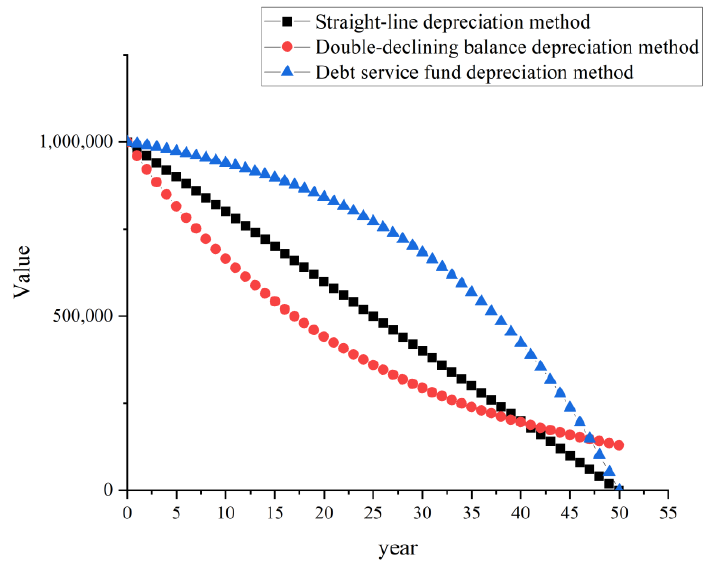
Figure 1. Comparison of different depreciation methods.